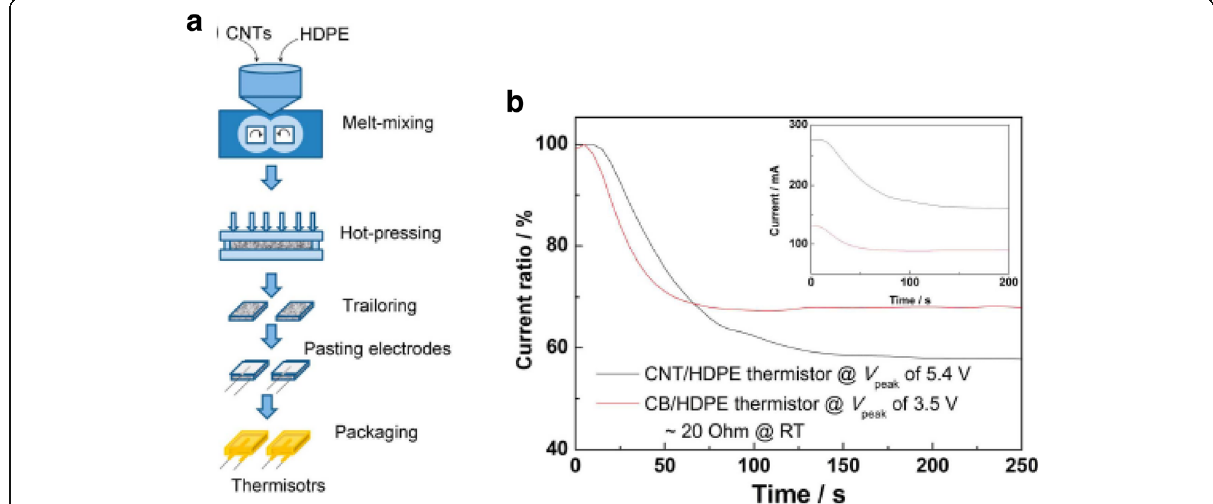
Fig. 34 a Schematic of the fabrication of CNT/HDPE thermistors using melt mixing. The process consists of melt-mixing, hot-pressing and packaging. Adapted from [245]. b Graph comparing the current vs time plots of CNT/HDPE and CB/HDPE thermistors. The comparison of the current decay between the CNT/HDPE and CB/HDPE thermistors with the same resistances under peak applied voltages shows a quick response of current delay of the CNT/ HDPE thermistors. Adapted from [245]